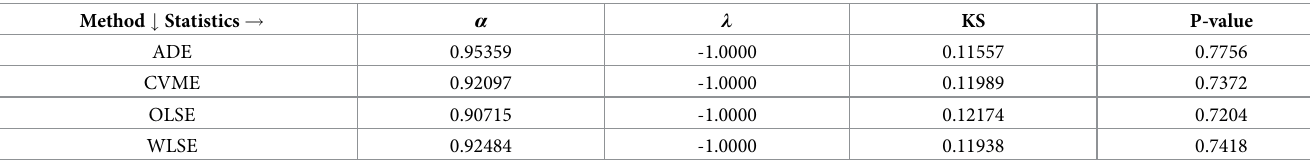
Table 9. Different estimation methods for the dataset.